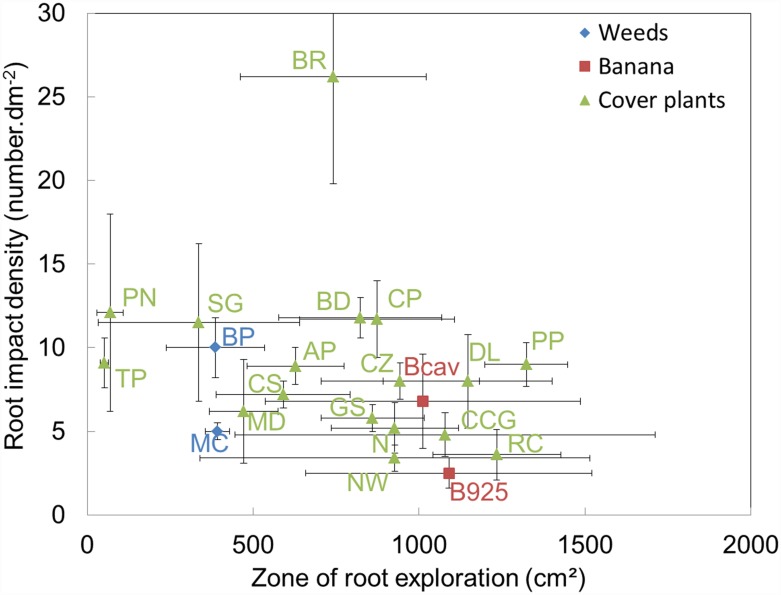
Species distributions regarding the relationship between total root-impact density and root exploration zone.See Table 2 for the species names. (n = 4 replicates for all species except BD (n = 3)).